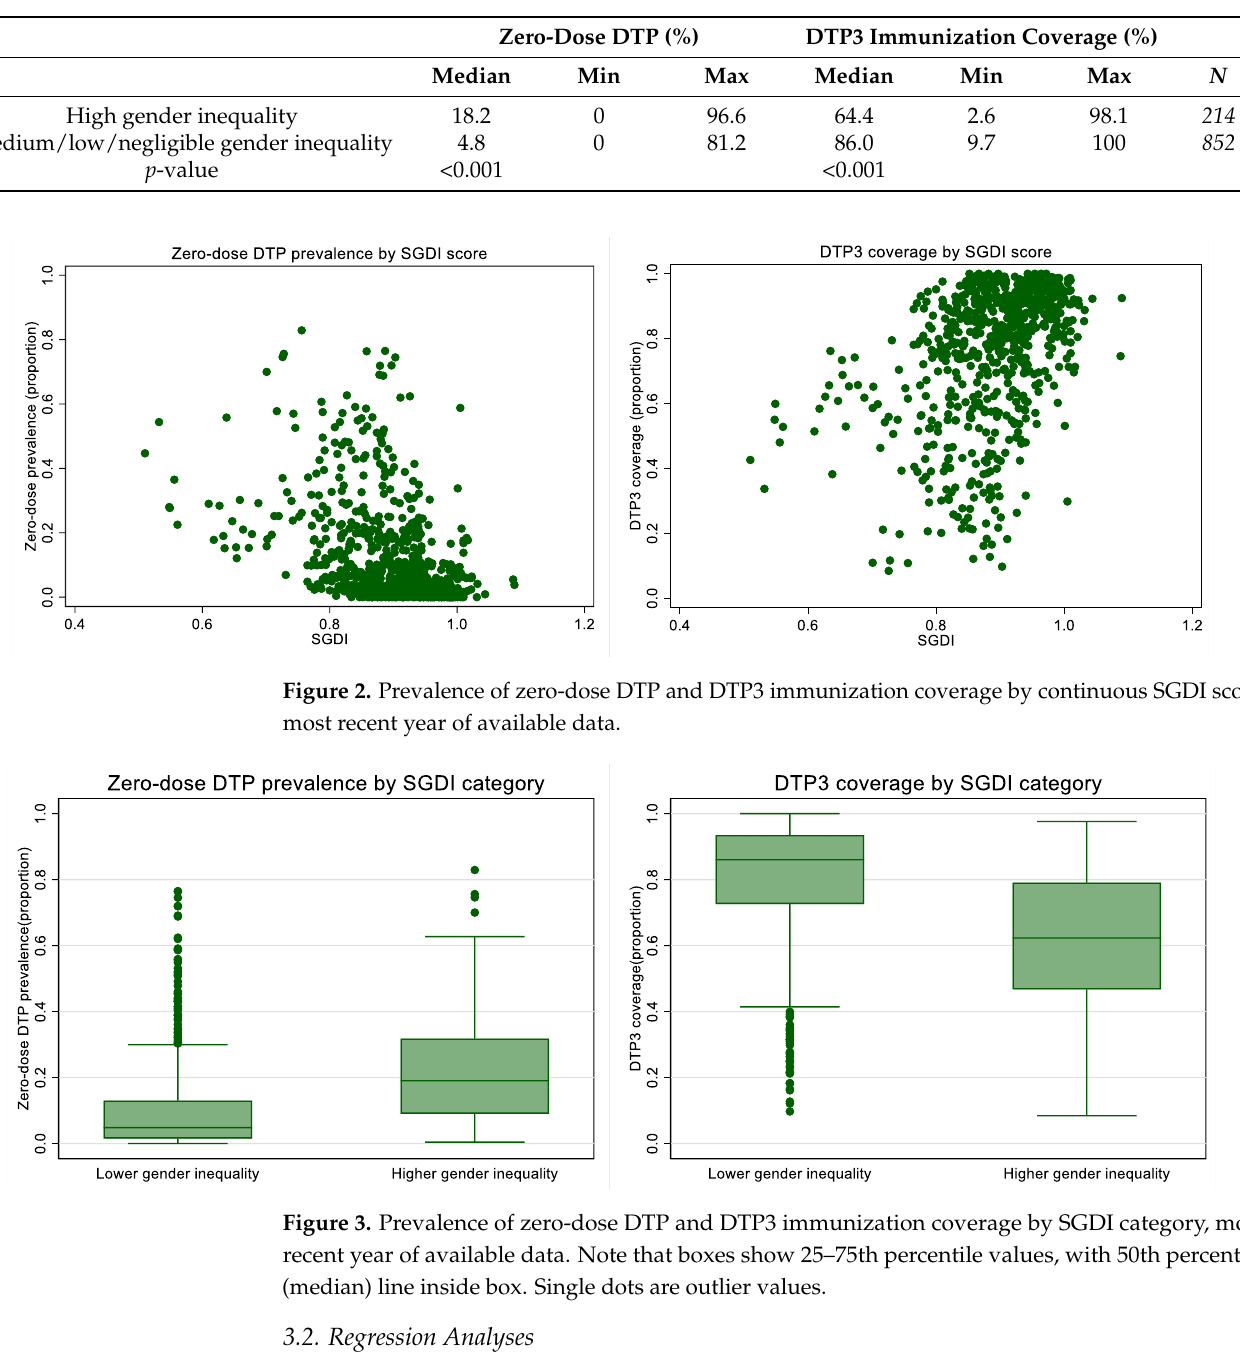
Table 3. Odds ratios for zero-dose DTP prevalence and DTP3 immunization coverage by SGDI cat- egory (702 subnational regions across 57 countries, 2010-2019).